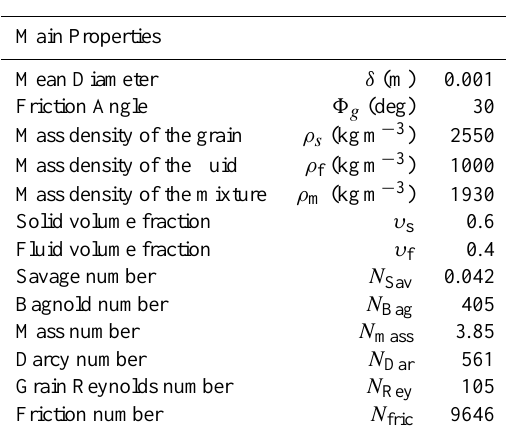
Table 1. Main properties of the mixture used in the laboratory